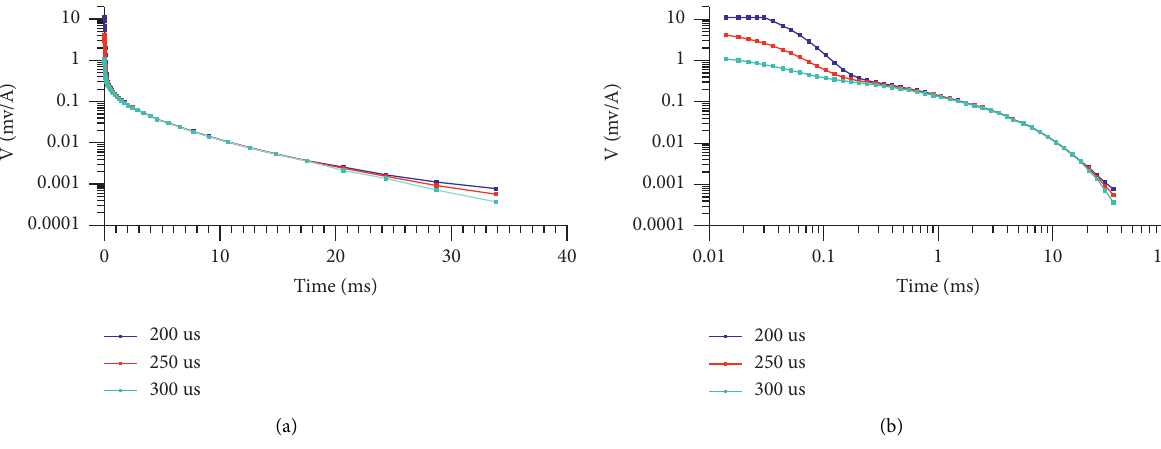
Figure 6: Comparison of V ( t )/ I attenuation curves of receiving delay of 200 µ s, 250 µ s, and 300 µ s. (a) 0–40ms. (b) 0.01–100ms.